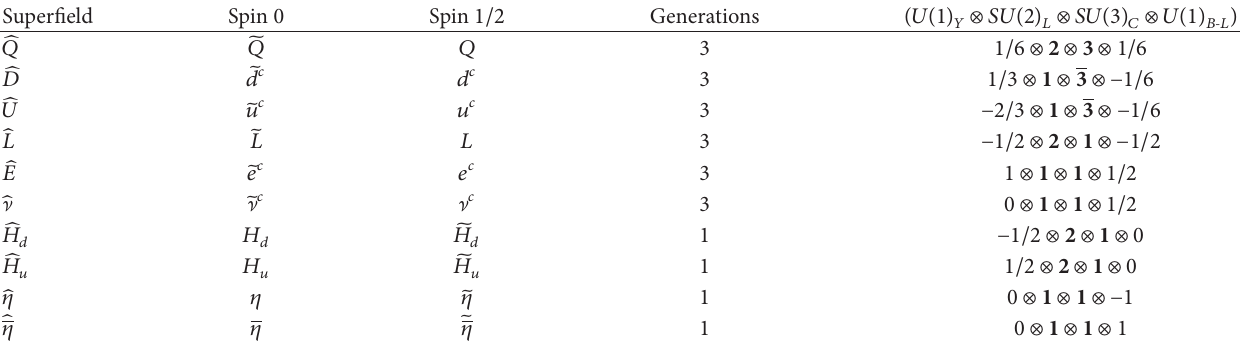
Table 1: Chiral superfields of the B-L- SSM and their quantum numbers under 𝑈(1) 𝑌 ⊗ 𝑆𝑈(2) 𝐿 ⊗ 𝑆𝑈(3) 𝑐 ⊗ 𝑈(1) 𝑌 𝑈(1) 𝐵−𝐿 .